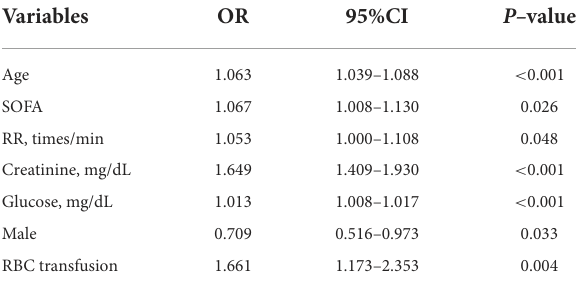
TABLE 2 Multivariate logistic regression analyses of independent predictors for 1-year all-cause death in the elderly patients with cardiac